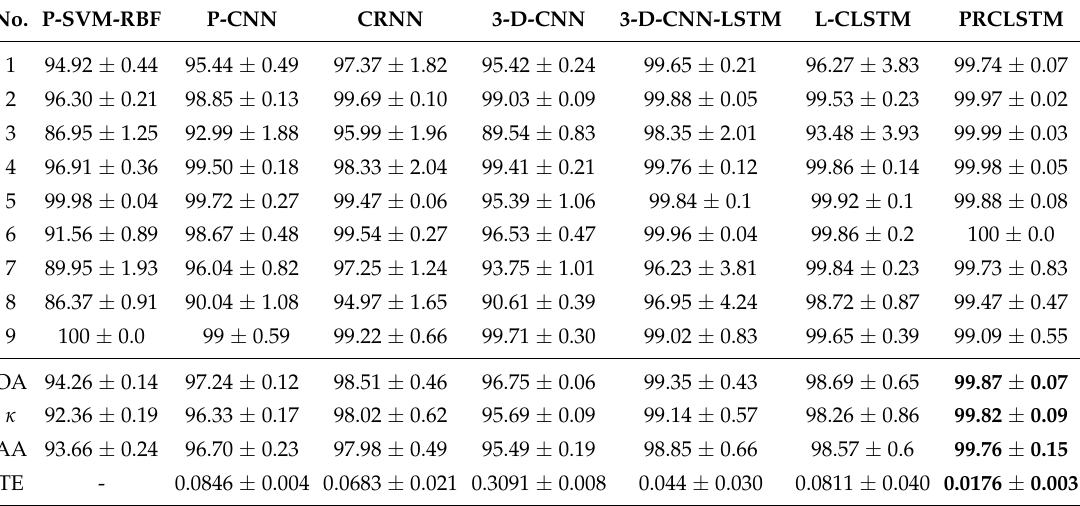
Table 6. A comparison between the classification results of the PaviaU dataset with a fixed spatial size of the input cube and a sufficient number of training samples.